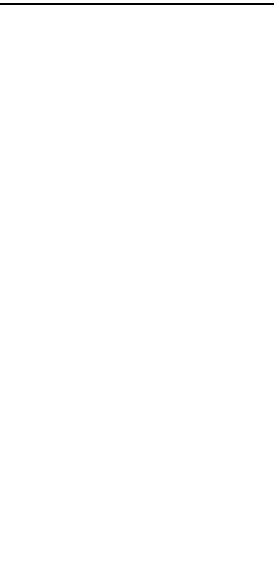
Table 6. Gender differences regarding the type of device the participants prefer to use to